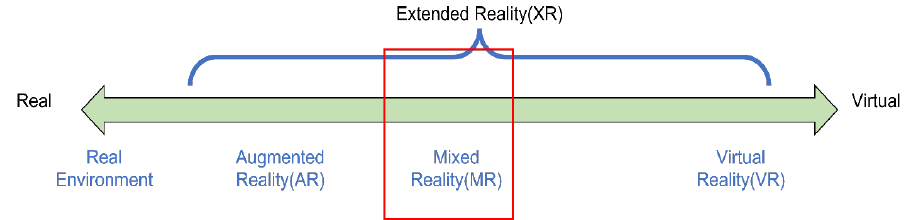
Figure 1. The concept of mixed